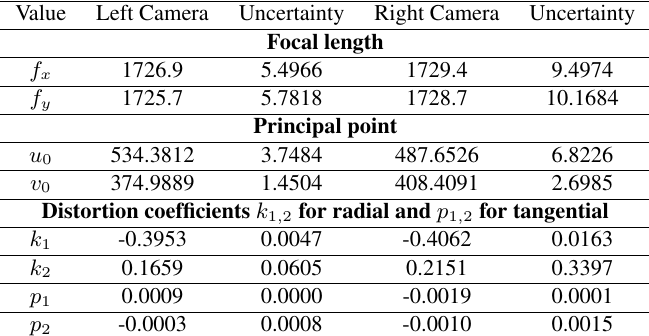
Table 1. Camera calibration results for Passive and Active Stereoscopy